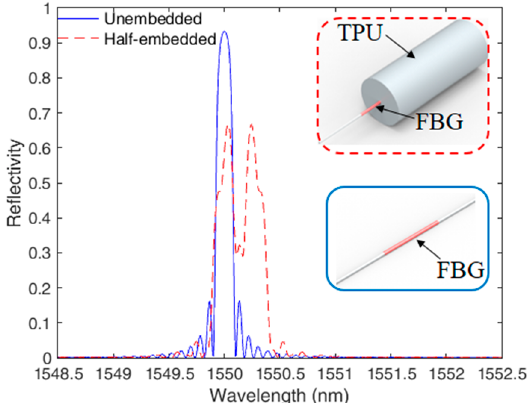
Table 1. Parameters employed in the gratings simulation.